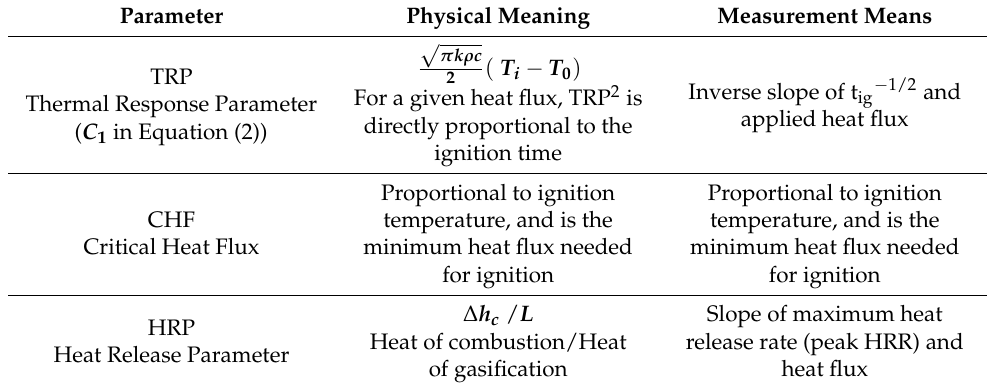
Table 1. Summary of the studied flammability parameters of PVC cable, after Quintiere [10].